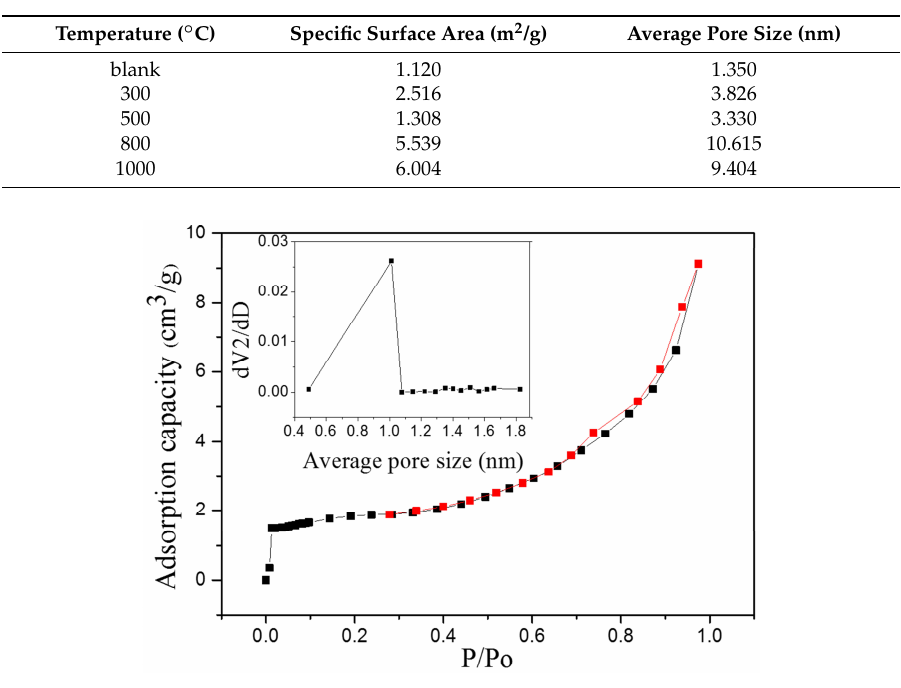
Figure 2. Isothermal adsorption curve and pore size distribution curve of CMSP.